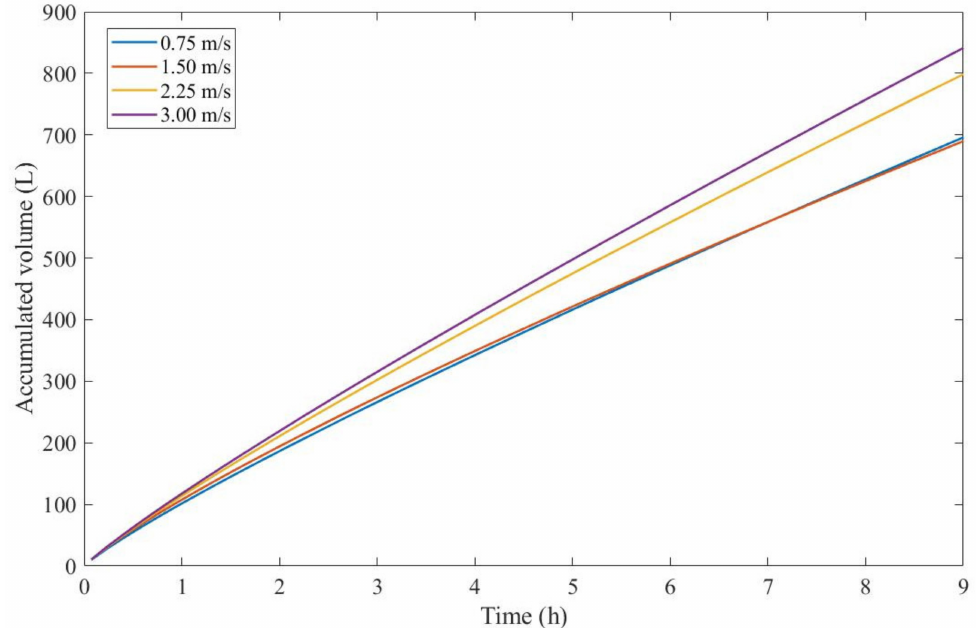
Figure 4. The accumulated volume calculated through the EHM for ultrafiltration of flooding wastewater at 2.20 bar and cross-flow velocities of 0.75–3.00 m/s, assuming j 0 = 100 L/m 2 h and A = 1.567 m 2 .